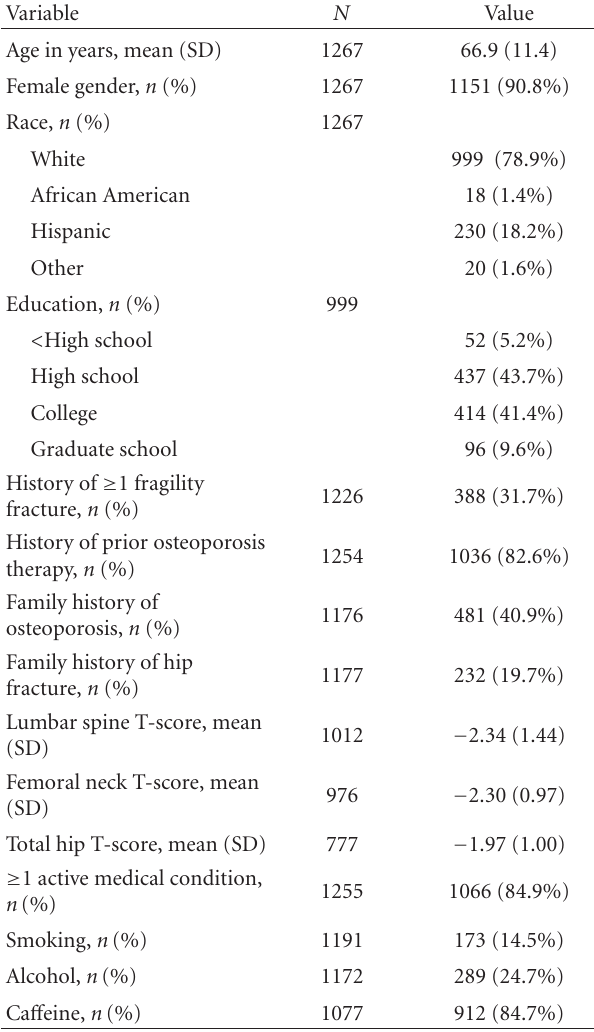
Table 1: Demographics and baseline characteristics. Table 2: Reasons given for discontinuation of teriparatide therapy for those patients who reported early or late